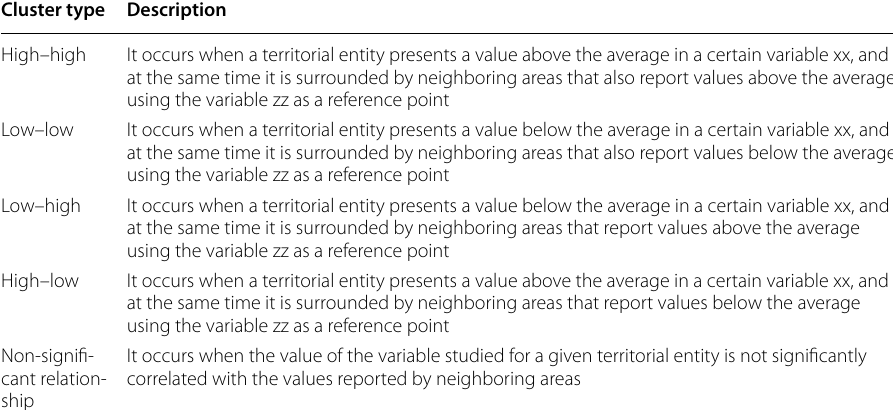
Table 3 Cluster spatial groupings derived from the local IM Cluster type Description